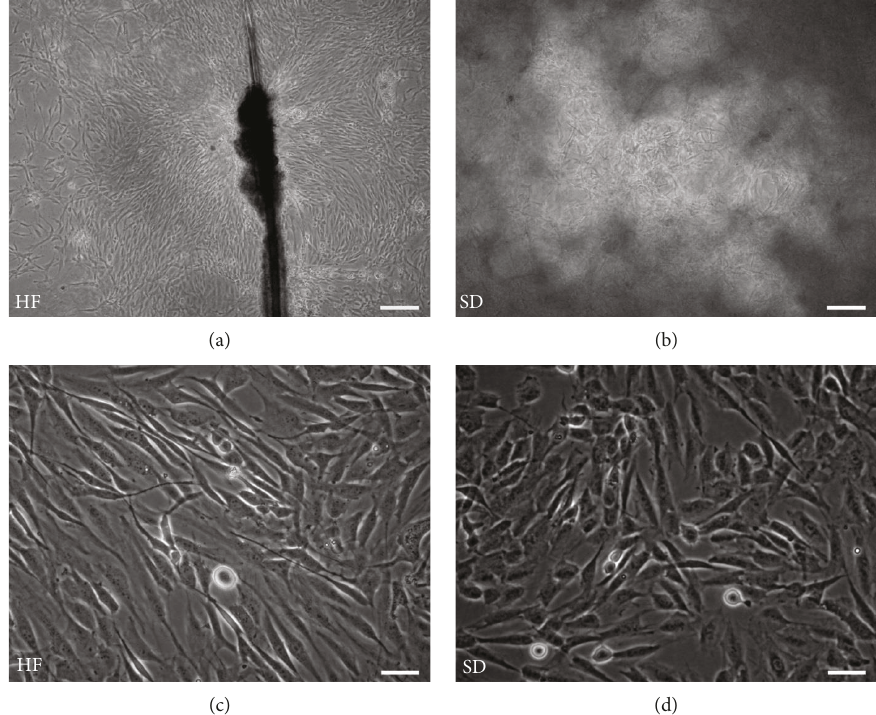
Figure 1: Cell morphology of adult NCSCs isolated from hair follicle and skin dermis. (a) Hair follicle explant demonstrates net outgrowth of HF NCSCs; (b) SD NCSCs within 3D fi brin hydrogel; (c) fi broblast-like morphology of HF NCSCs at passage 1; (d) polygonal morphology of SD NCSCs at passage 1. Phase-contrast microscopy. Scale bar: (a, b) 200 μ m; (c, d) 50 μ